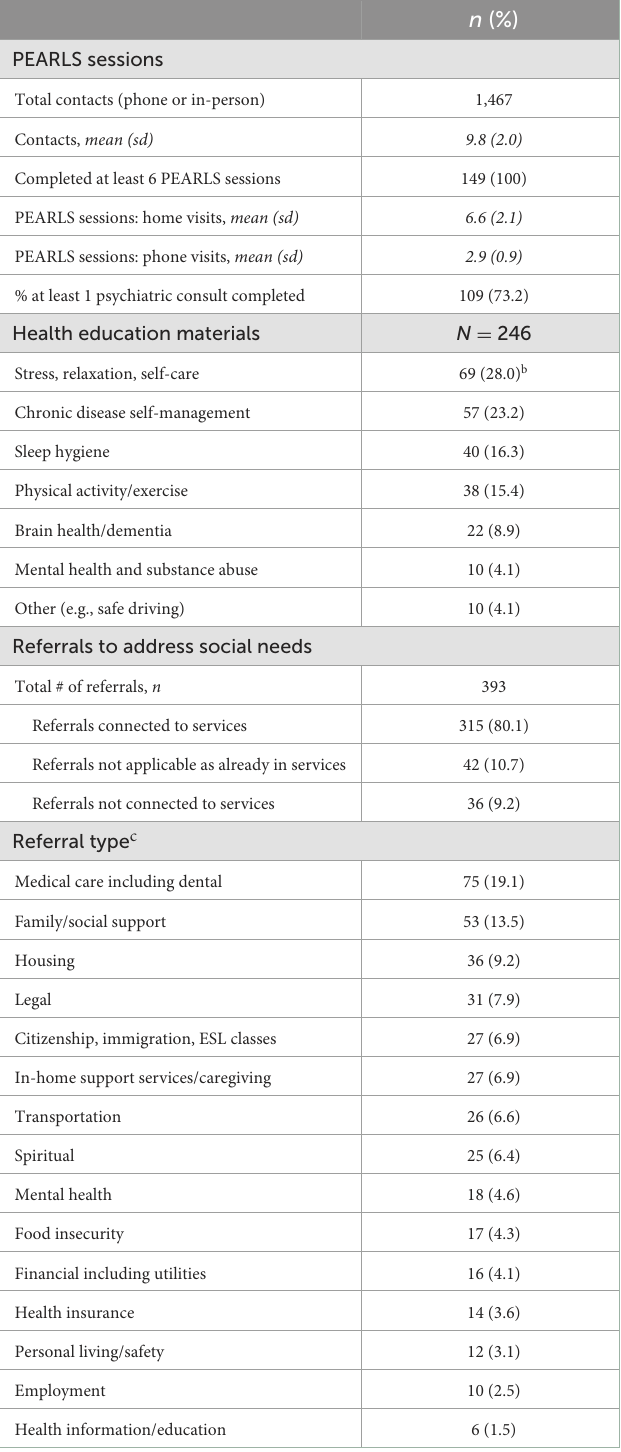
TABLE 5 PEARLS process of care: sessions, health education, social needs referrals ( N = 149) a